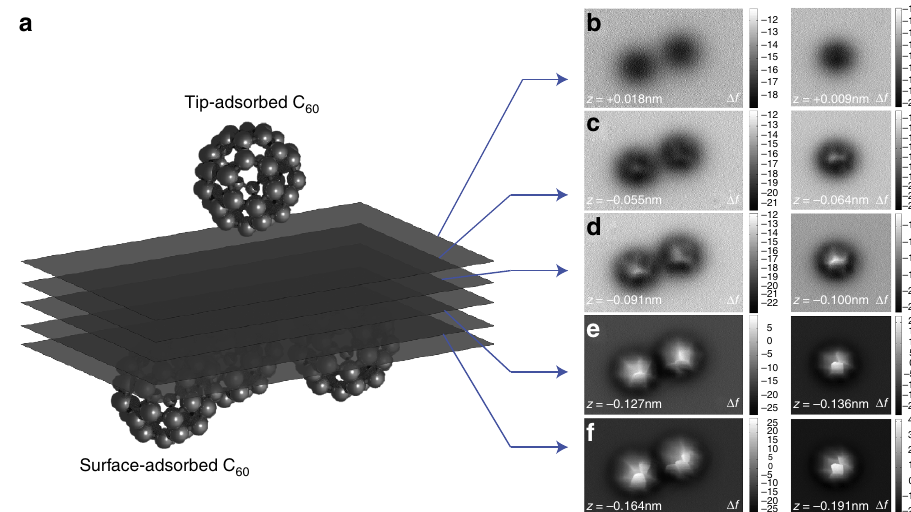
Figure 1 | Experimental data acquisition protocol. ( a ) cartoon showing the method of data acquisition for 3D potential mapping—a single C 60 molecule is attached to the tip of the scanning probe microscope and brought close to a group of surface-adsorbed molecules. Constant height scans are acquired at decreasing tip-sample separation, with active drift compensation between each scan, and the variation in the frequency shift D f measured. ( b – f ) representative D f images (in Hz) at decreasing tip-sample height. Tip-sample heights shown for each image are given relative to the D f set point used for atom-tracking over the molecule. The slightly different z heights for the two data sets result from the slightly different tracking heights used in each case. Image sizes: 3.5 (cid:2) 2.2nm 2 and 2.5 (cid:2) 2.5nm 2